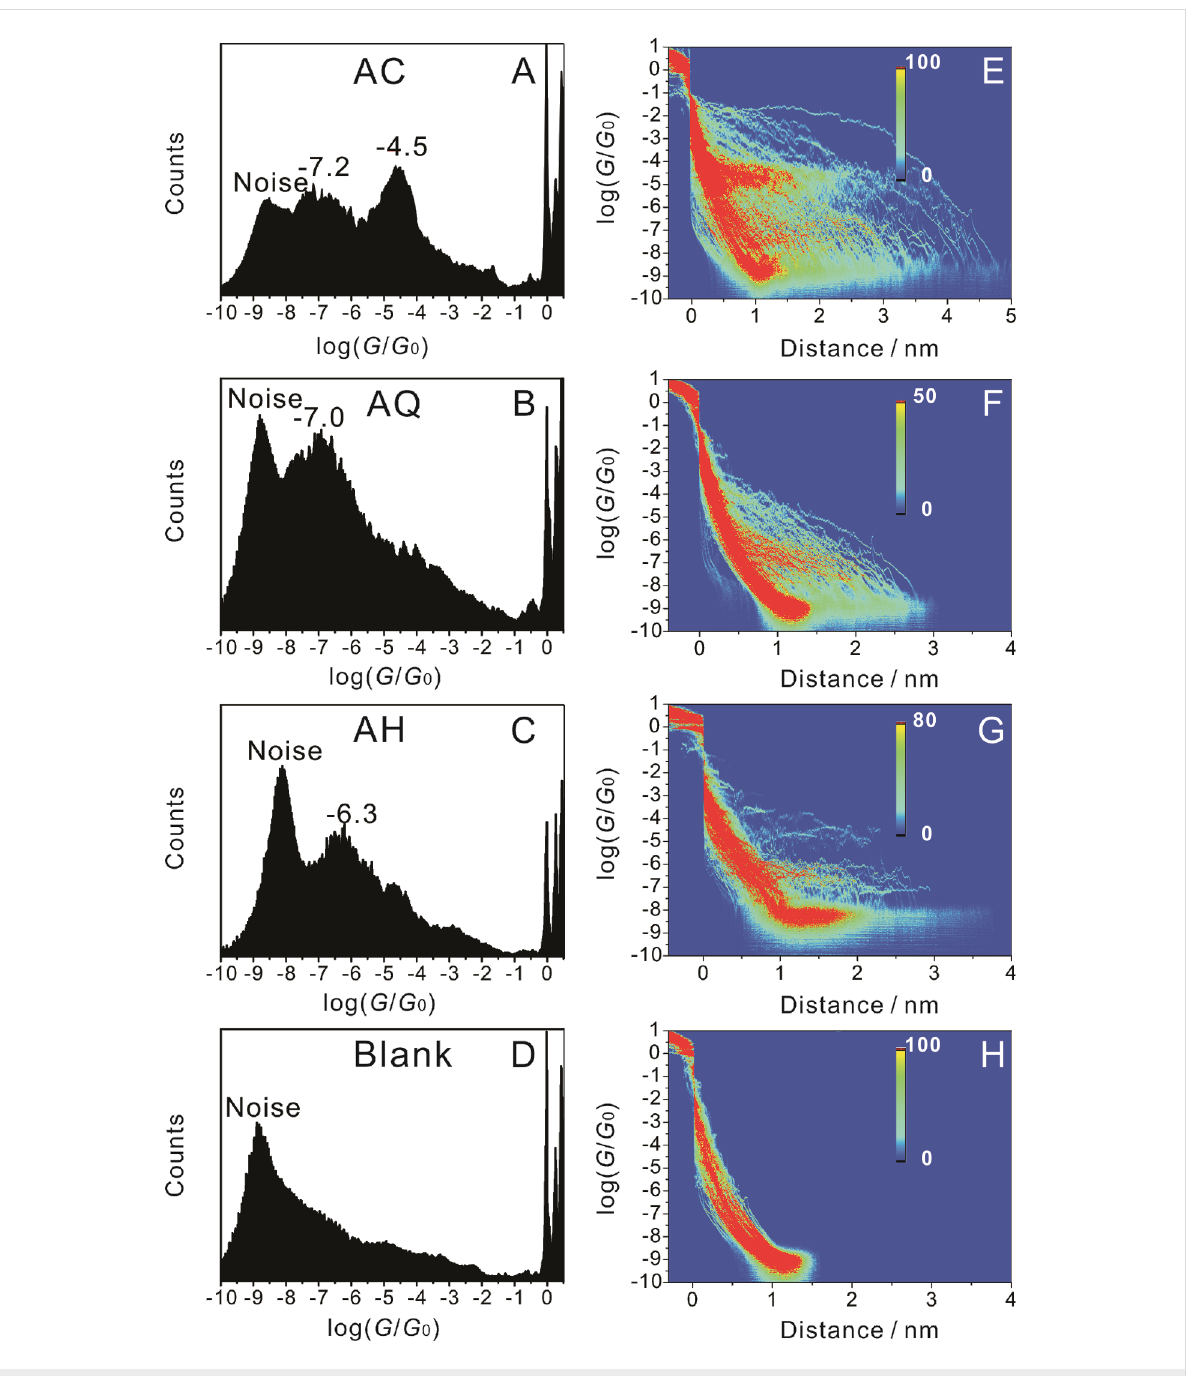
Figure 8: 1-D conductance histograms and conductance–distance 2-D histograms constructed from 500 individual traces of AC (panels A and E), AQ (panels B and F), AH (panels C and G) and for the blank control experiment (panels D and H) in THF/decane (v:v = 1:4) under Ar atmosphere at 0.10 V bias voltage in the MCBJ setup. The molecule concentration was 0.1 mM, and the stretching rate was around 1 nm · s -1 .